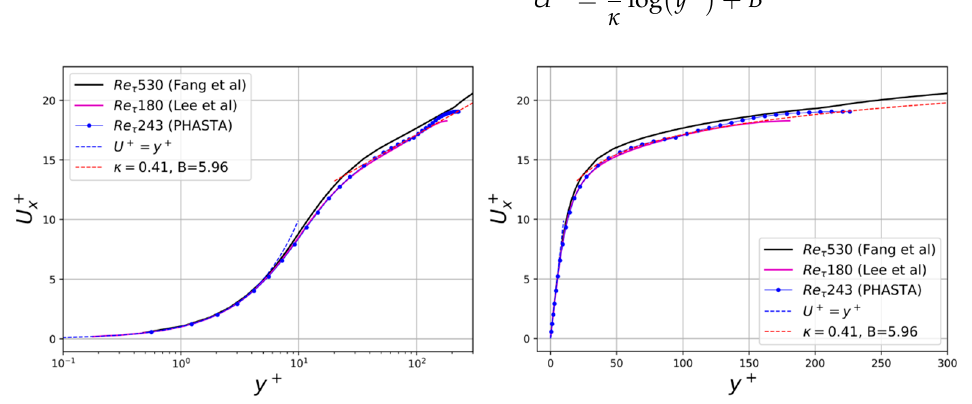
Figure 4. Comparison of mean normalized streamwise velocity profile at the inlet cross-section with direct numerical simulation (DNS) data from Lee et al. [52] and Fang et al. [60].